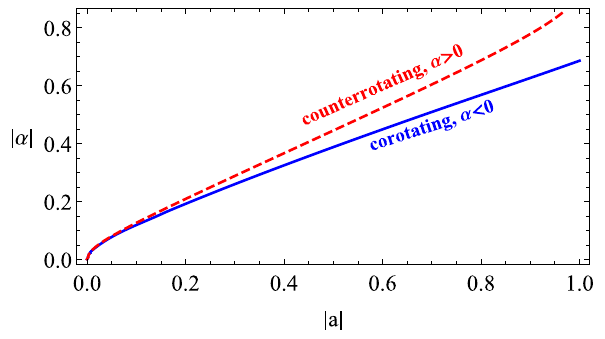
Fig. 11 Relations between MOG and rotation parameters giving the same ISCO of the magnetized